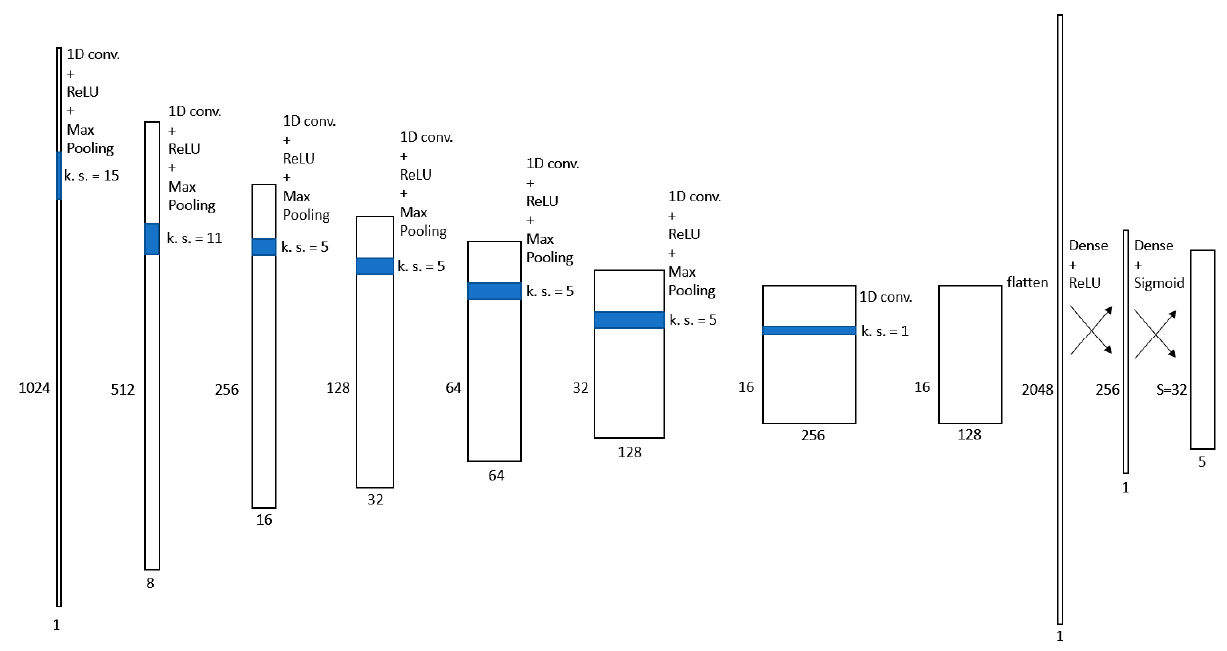
Figure 2. Neural network proposed for the localization and characterization of the faults.